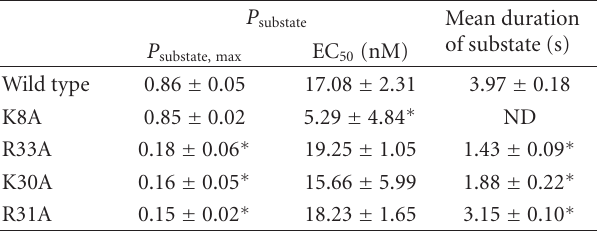
Table 2: E ff ects of the mutant IpTx a on P substate of purified RyR1. EC P P substate, max and 50 for substate of purified RyR1 were calculated as described in the legend to Table 1. Values are means ± SE of 4–10 experiments. The average lengths of the substate events were determined at 30 nM concentration. Asterisks indicate significant di ff erences from the wild type for each parameter (Student t -test , P < 0 . 05). ND: not determined. P substate Mean duration of substate (s) P substate, max EC 50